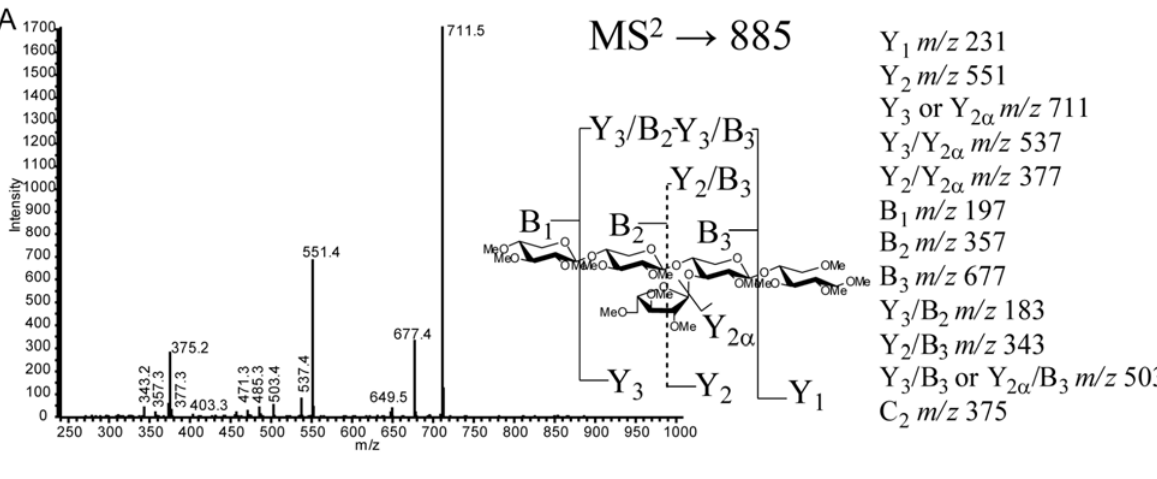
Figure 7. MS n fragmentation of permethylated oligosaccharide XVII (RT 27.5 min) ( a ) MS 2 m/z 885. ( b ) MS 3 fragmentation m/z 885 → 711. ( c ) MS 4 fragmentation m/z 885 → 711 → 551. ( d ) MS 4 fragmentation m/z 885 → 711 →